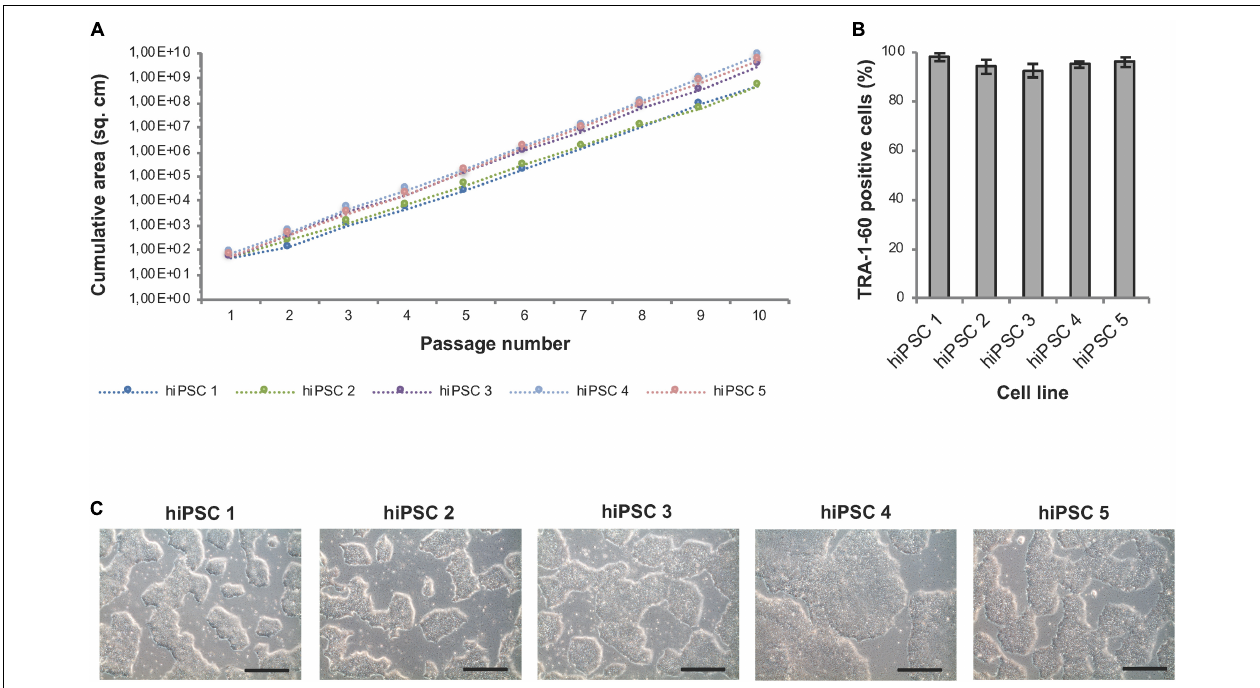
FIGURE 8 | Automated expansion of hiPSCs in 6-well plates. Five distinct hiPSC lines were automatically expanded in 6-well plates using Geltrex coating and E8 medium. Dilution ratios were determined via well-specific confluence measurements. (A) HiPSC lines expanded via the StemCellFactory show constant and exponential cell growth over 10 passages. Passaging was performed every 3–4 days. (B) Flow cytometry analysis was performed after each passage and showed a high expression of TRA-1-60 in all evaluated cell lines. Data are taken from every passage and shown as mean ± SD ( n = 10). (C) Representative phase contrast images of hiPSC lines at passage 10. Scale bars: 100 µ